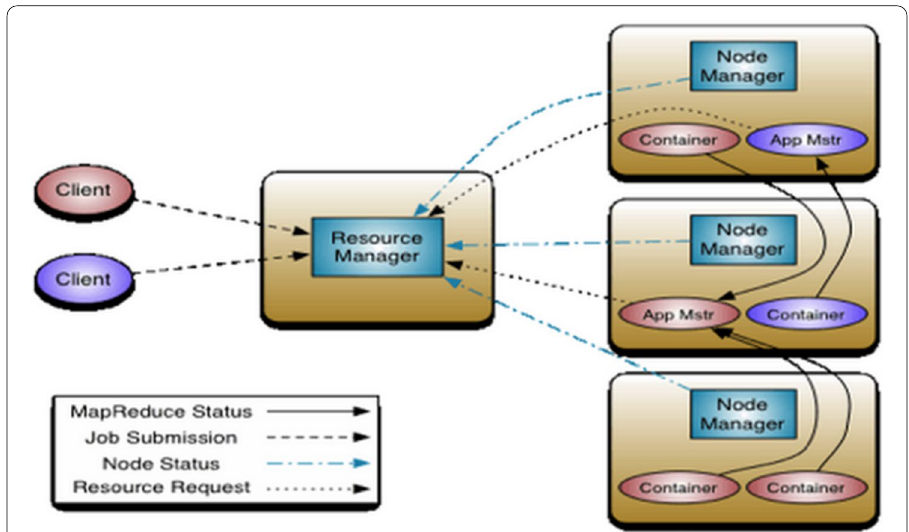
Fig. 4 The distributed data processing